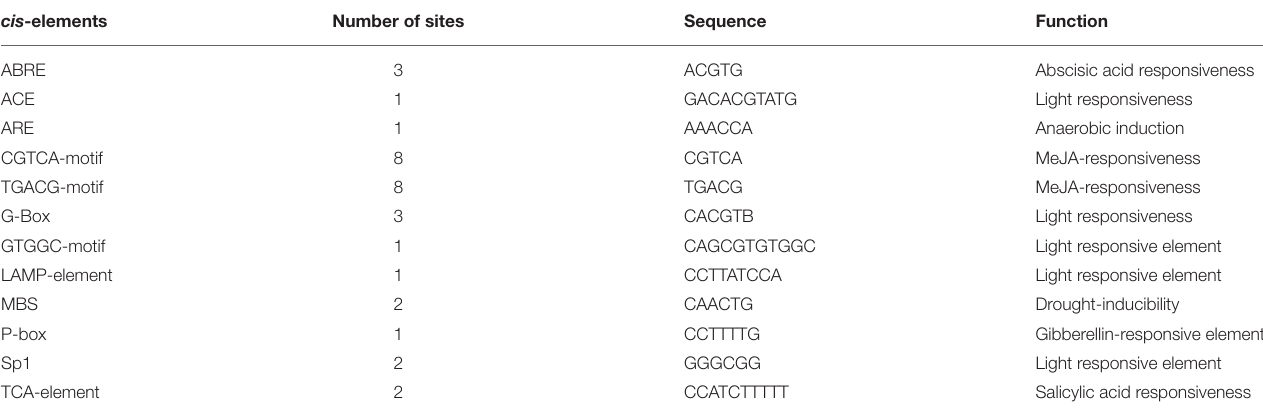
TABLE 1 | Stress-related cis -elements in the promoter region of HpGCN5 identified from the PlantCARE database.